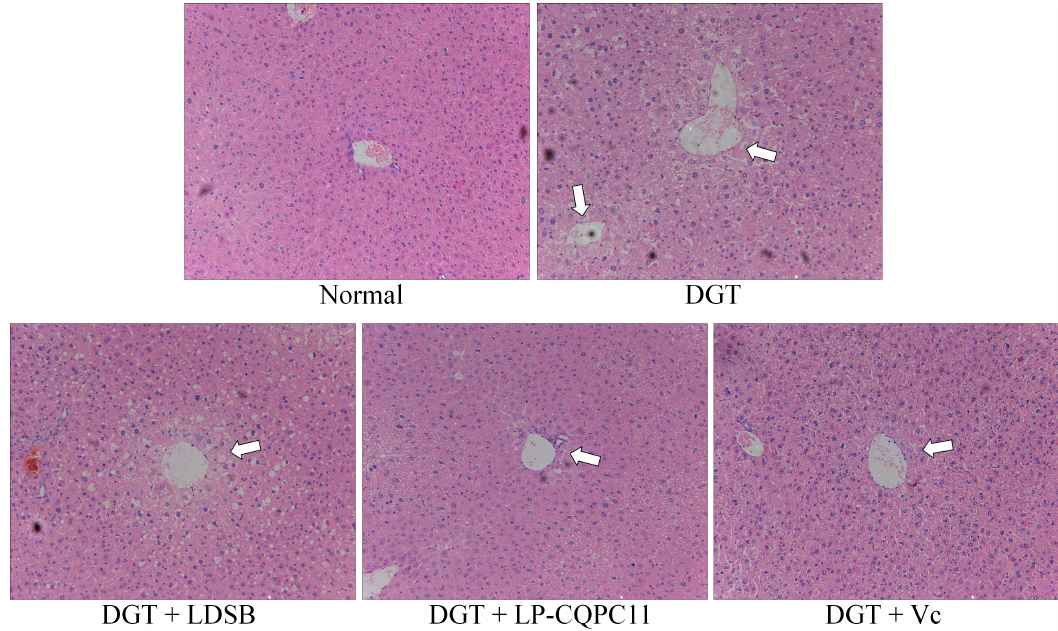
Figure 2. H&E pathological observation of liver in mice. Magnification 100× DGT: mice treated with D -galactose; DGT + LDSB: mice treated with D -galactose and Lactobacillus delbruechii subsp. bulgaricus (1.0 × 10 9 CFU/kg); DGT + LP-CQPC11: mice treated with D -galactose and Lactobacillus plantarum CQPC11 (1.0 × 10 9 CFU/kg); DGT + Vc: mice treated with D -galactose and vitamin C (200 mg/kg).